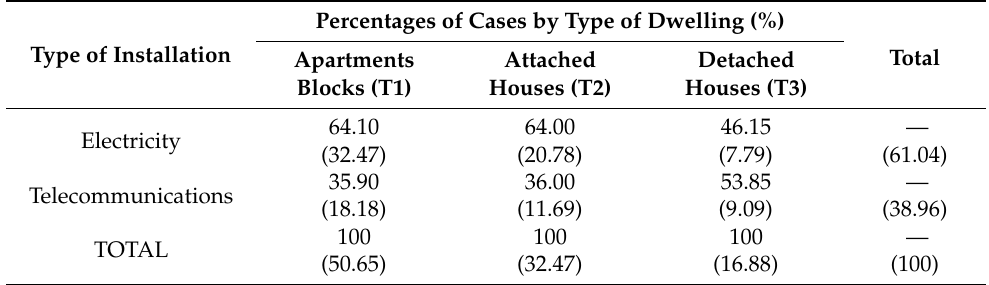
Table 3. Percentages according to each facility and type of dwelling according to the data set.